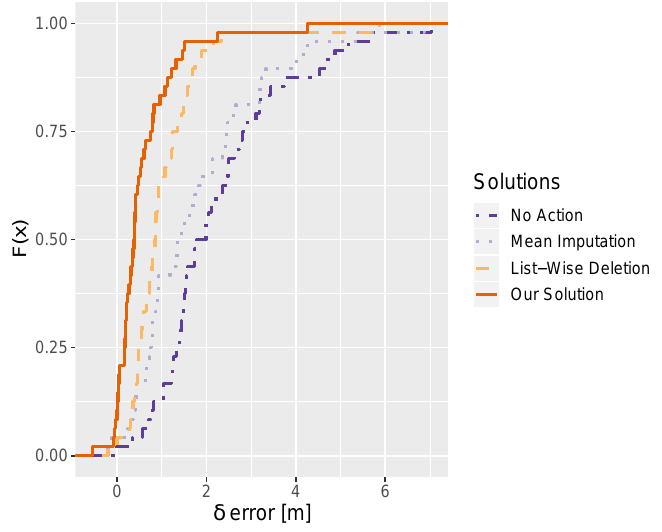
Figure 5. The comparison of the δ errors obtained for various preventing